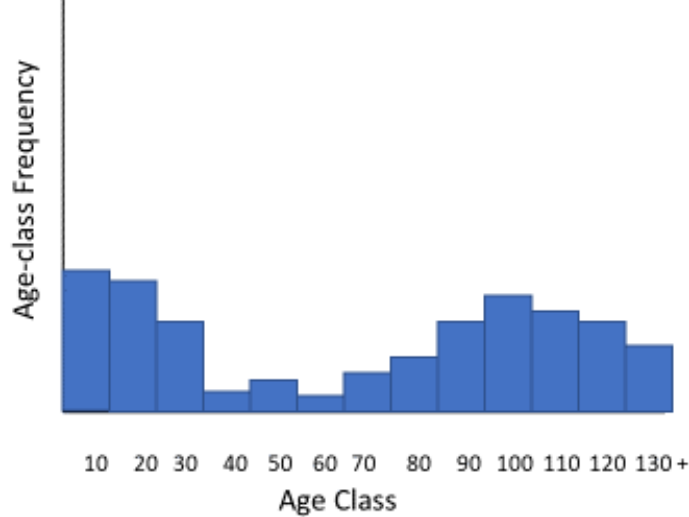
Figure 3. A hypothetical forest age class structure with excess mature stands and limited growing stock in mid-rotation stands. This type of forest is common in Alberta and would likely benefit from intensive silviculture that allows for increased harvesting of existing excess mature stands and bridges the mid-rotation timber supply gap.